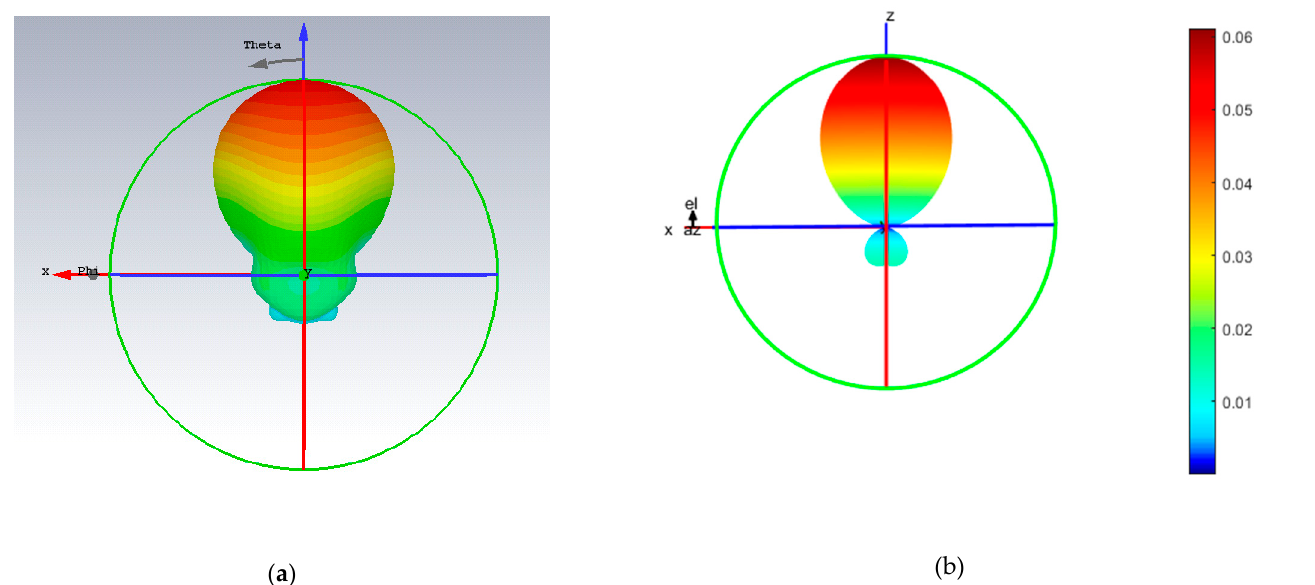
Figure 7. 3D reconstruction of the electric field radiated by the EUT; results of numerical simulations ( a ) and model prediction from measurement in RC environment ( b ) are reported.